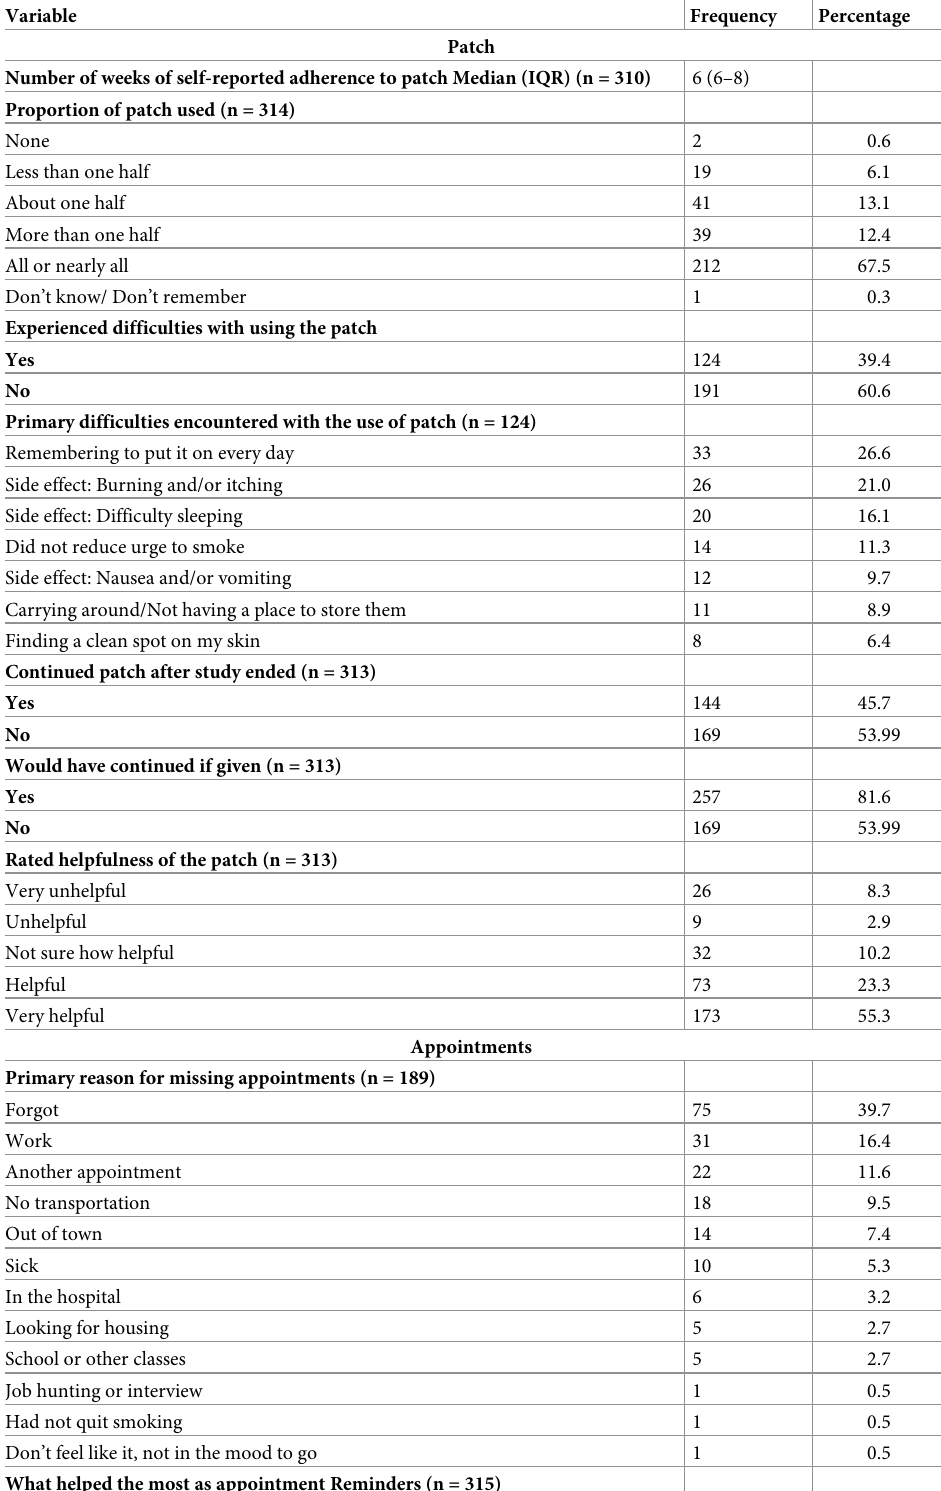
Table 2. Participants’ feedback on the patch, appointments, and counseling